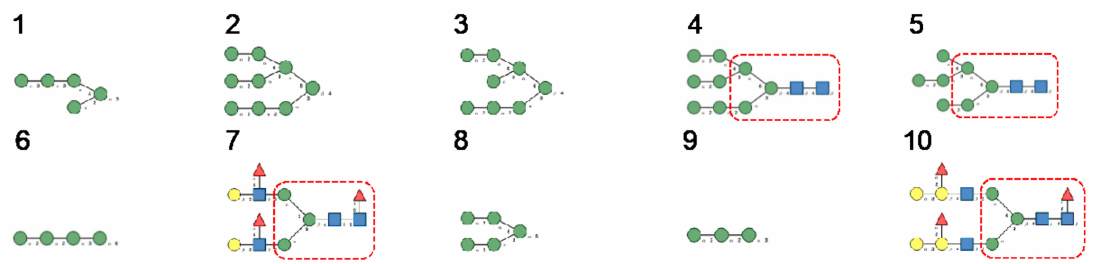
Figure 23. Glycans recognized by actinohivin in glycan array experiments, arranged from 1 to 10 in decreasing order of